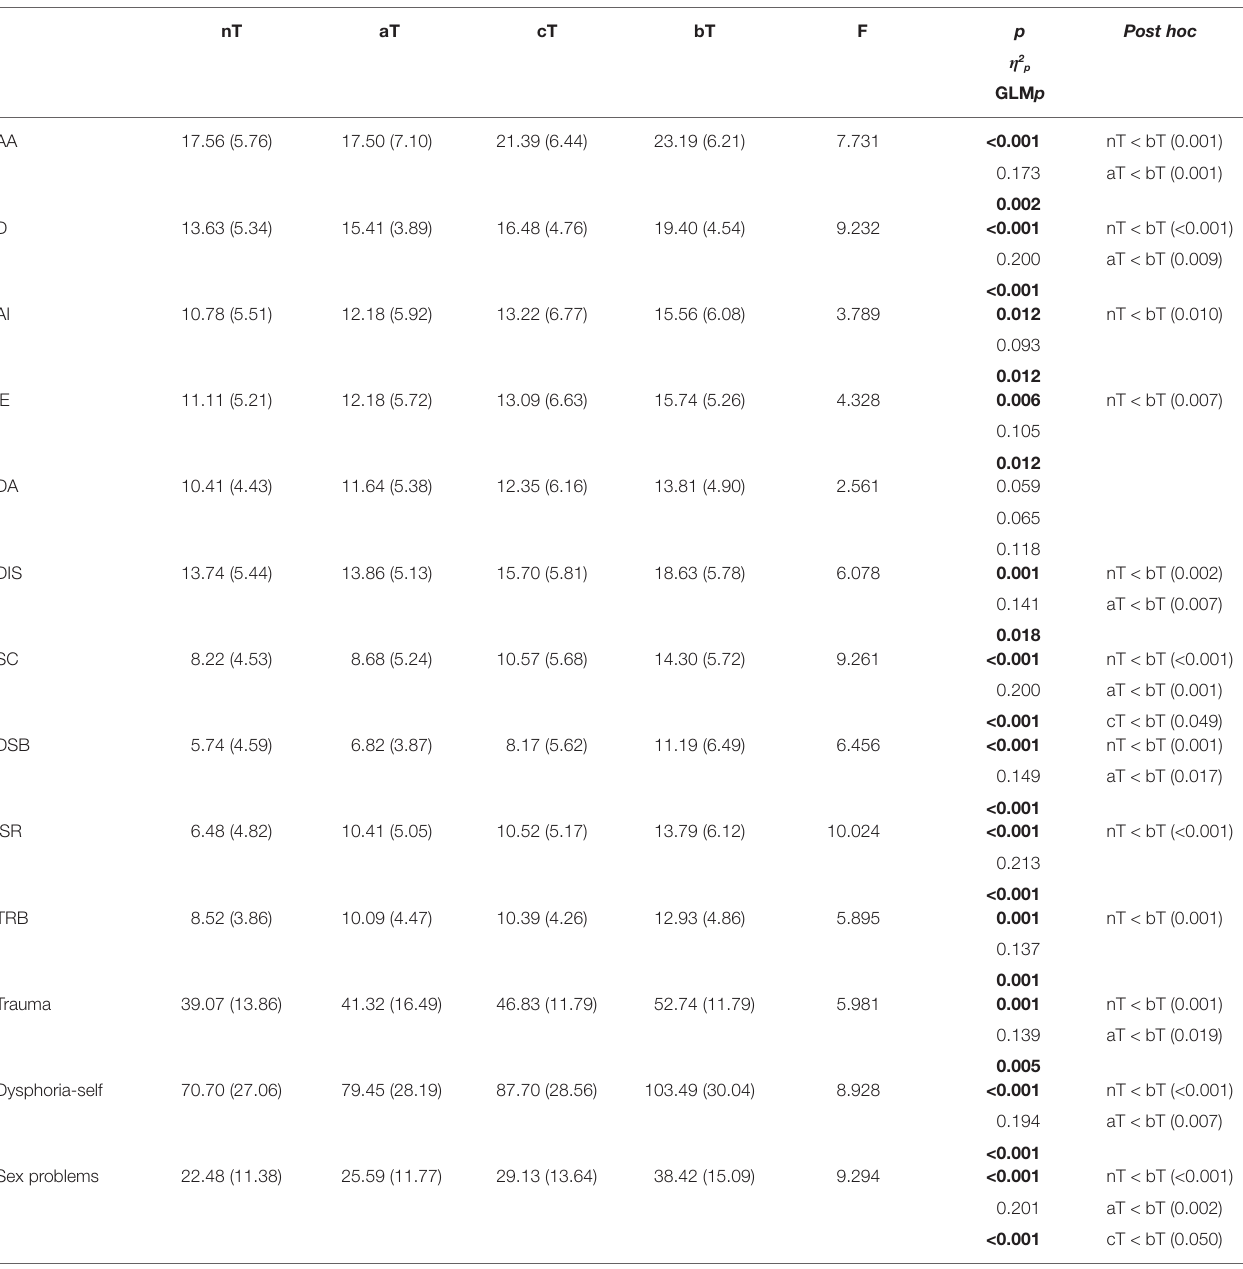
TABLE 2 | Trauma symptom